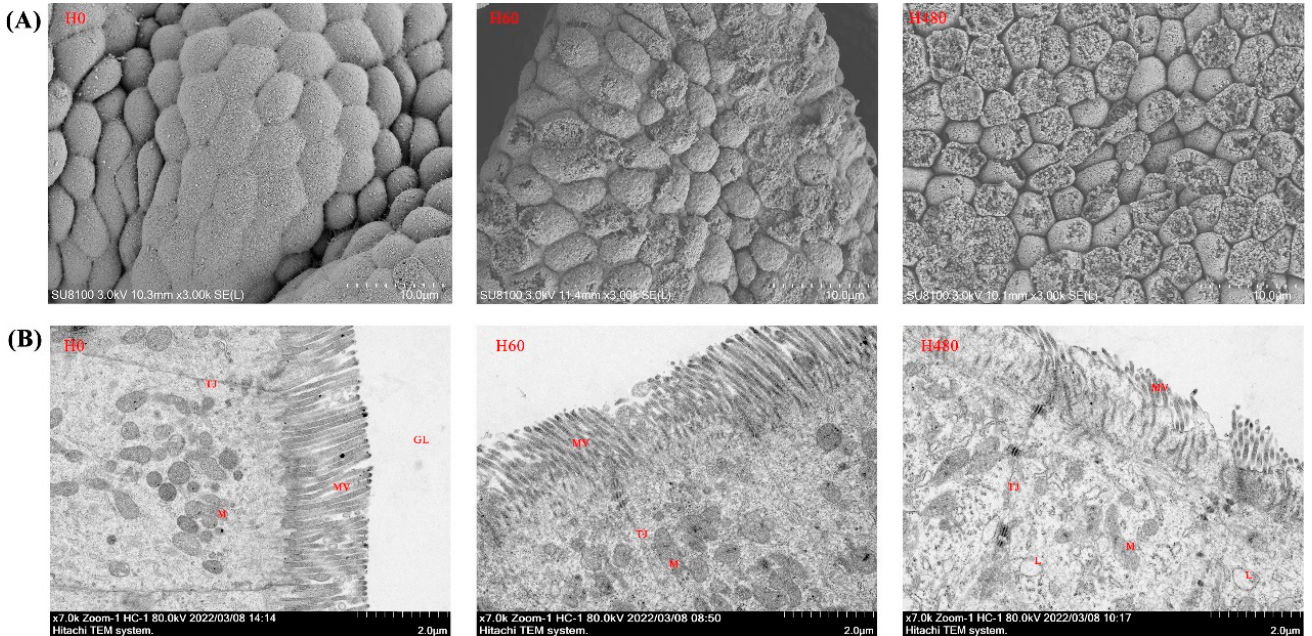
Figure 2. Gastric SEM and intestinal TEM observations of striped catfish fed with experimental diets. ( A ), gastric SEM observations; ( B ), intestinal TEM observations. M, mitochondria; TJ, tight junction; MV, microvillus; L, lysosome. Mitochondrial dissolution, lysosome volume increase, and microvilli damage were clearly observed in the H480 group.